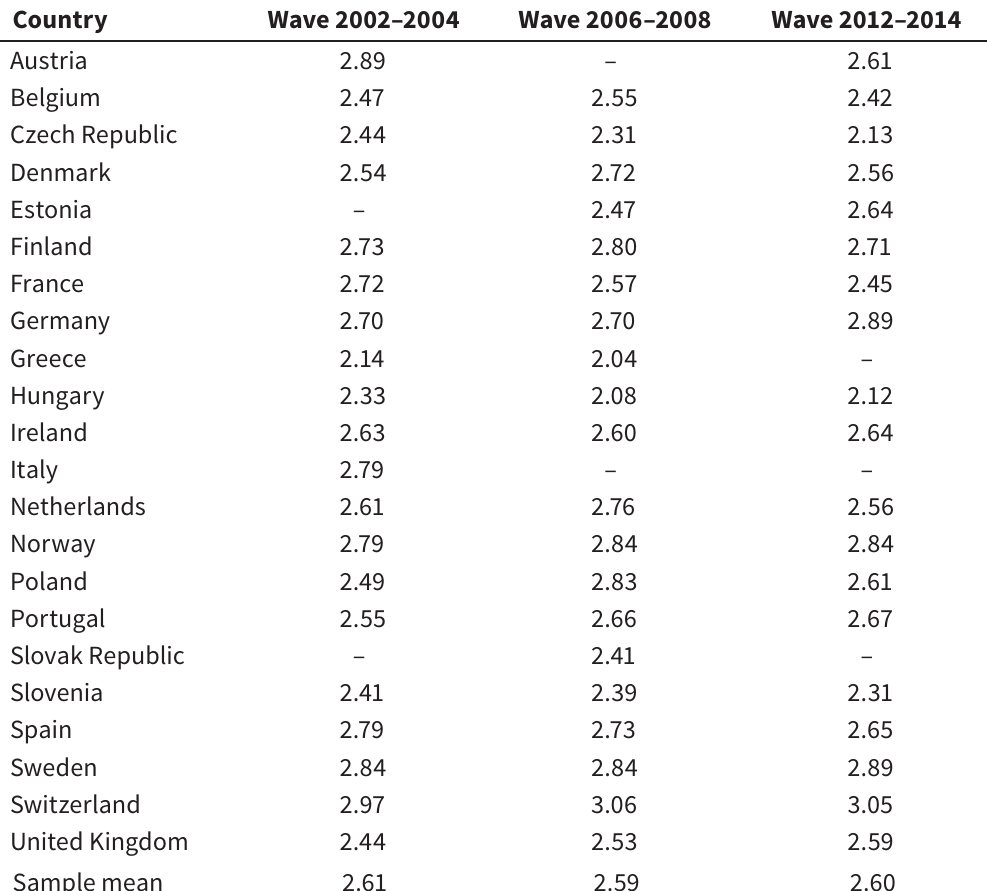
Table 1 Country trends toward immigration (“immigration is bad/good for a country’s